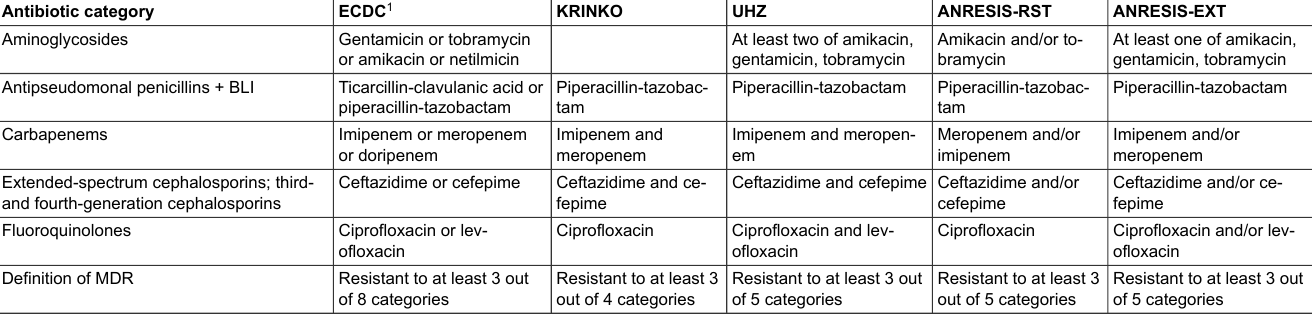
Table 2: Definition criteria and antibiotic panel for Pseudomonas aeruginosa.